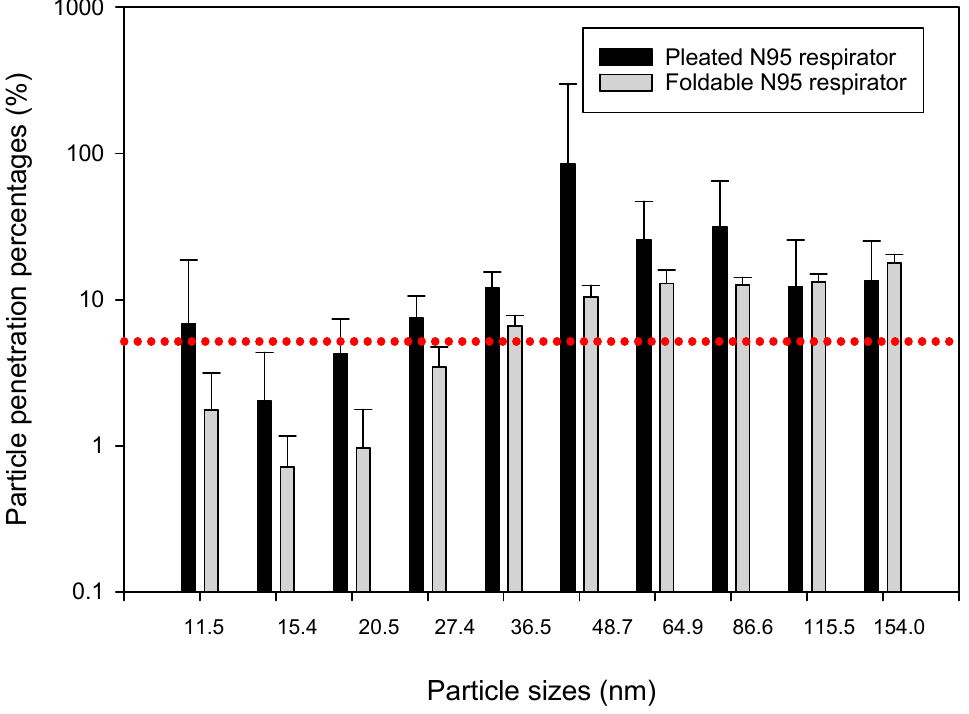
Figure 7. Penetration percentages of particles of 11.4–154.0 nm size range in isopropanol treated N95 masks during wooden building frameworks construction. The dotted red line indicates the 5% particle penetration percentages, to be considered as the efficacy threshold for N95 respirators.